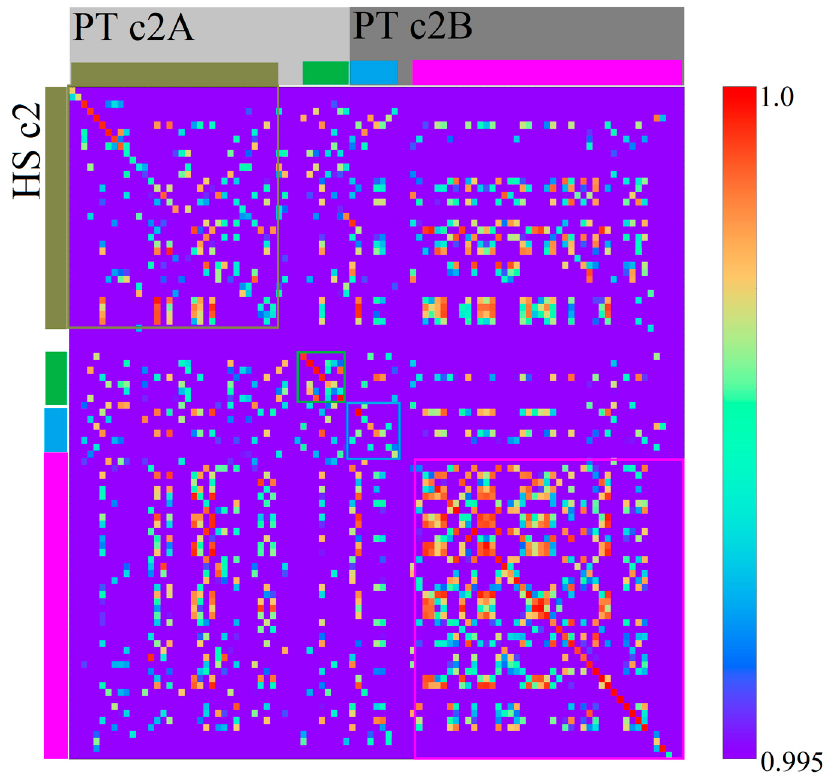
Figure 12. Correlation heatmap between Homo sapiens chromosome 2 (HSc2) and Pan troglodytes chromosome 2A (PTc2A) and 2B. Based on k = 4 (bin width 2.5 Mbp) with a highly increased threshold (see scale on the right). The colored boxes indicate regions of association between the chromosomes.